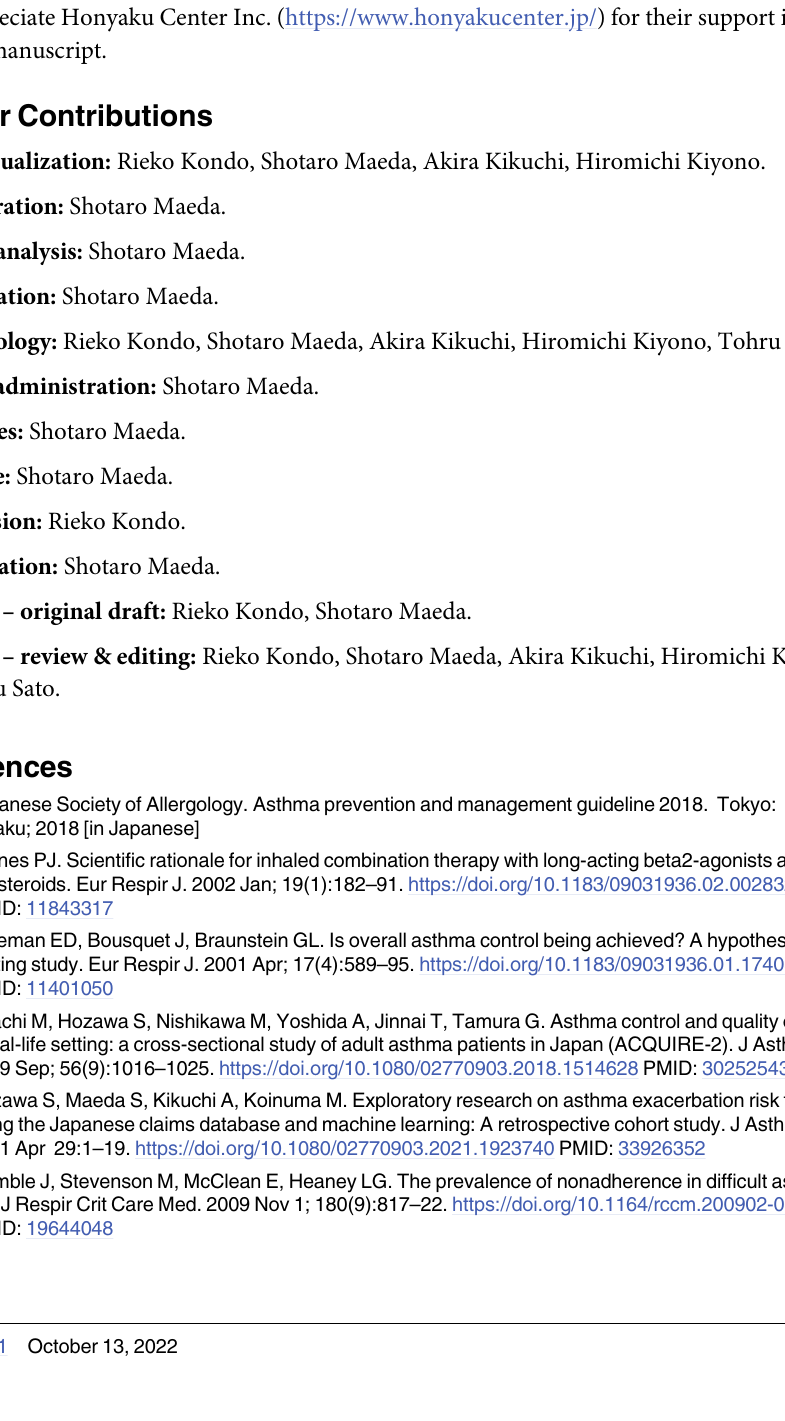
S5 Table. Differences in population distribution between MediScope 1 and the actual pop- ulation in Japan. S6 Table. ICS/LABA before and after switch. S7 Table. Data for primary and sensitivity